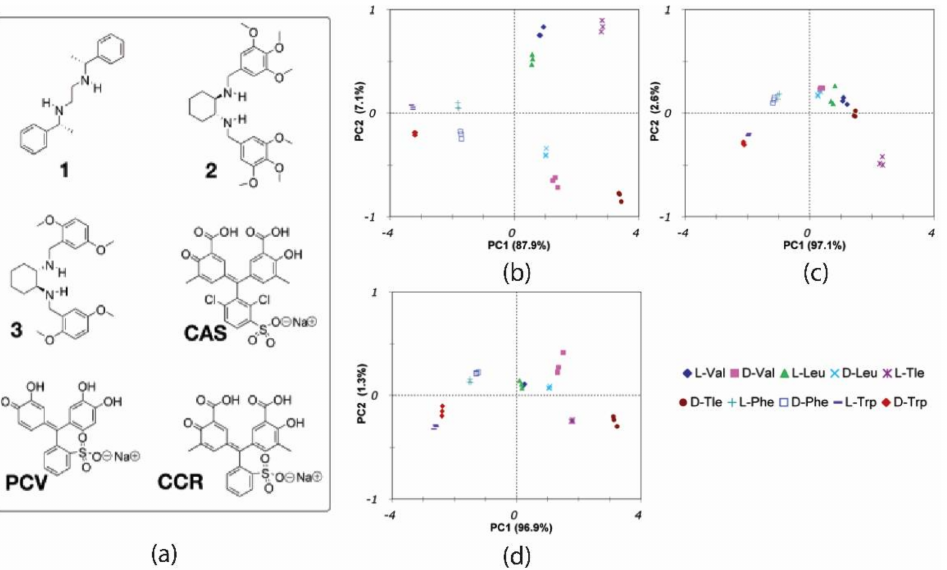
Figure 7. ( a ) Molecular structures of receptors and indicators used by Anslyn’s group. PCA plots from data for: ( b ) all 21 enantioselective IDAs, ( c ) 8 IDAs selective for D-amino acids, and ( d ) 13 IDAs selective for L configuration. Adapted from Ref. [39] with permission from the American Chemical Society, copyright